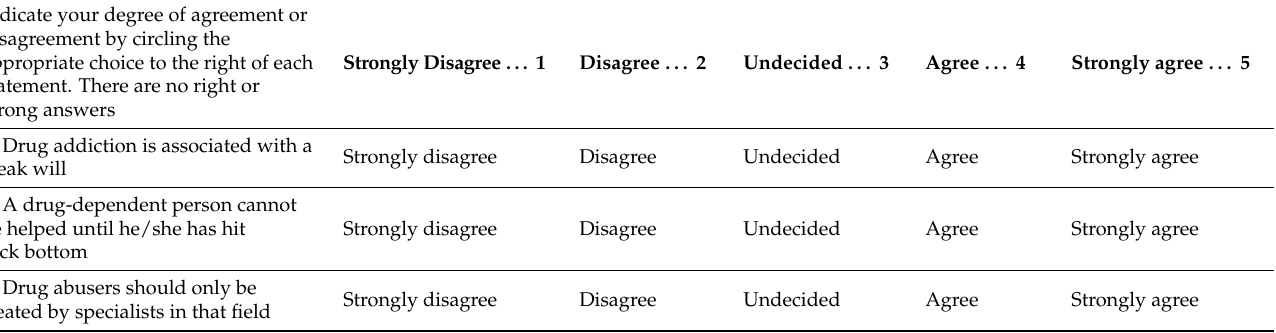
Table A2. beSAAS questionnaire (23